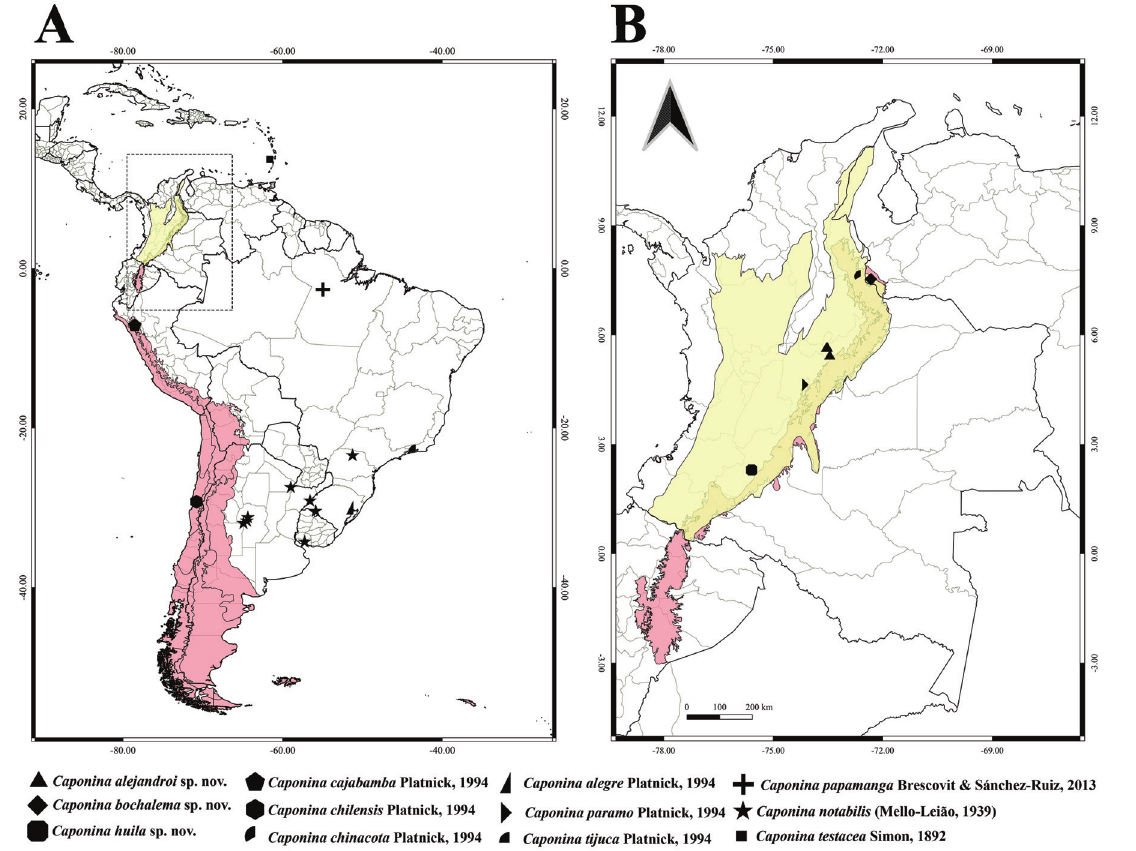
Fig. 6. Distribution map of species of Caponina . A . General distribution in the Neotropics, excluding Colombian species. B . Distribution of Colombian species. Total extension of Andean cordillera in South American is represented in pink and Colombian Andes in